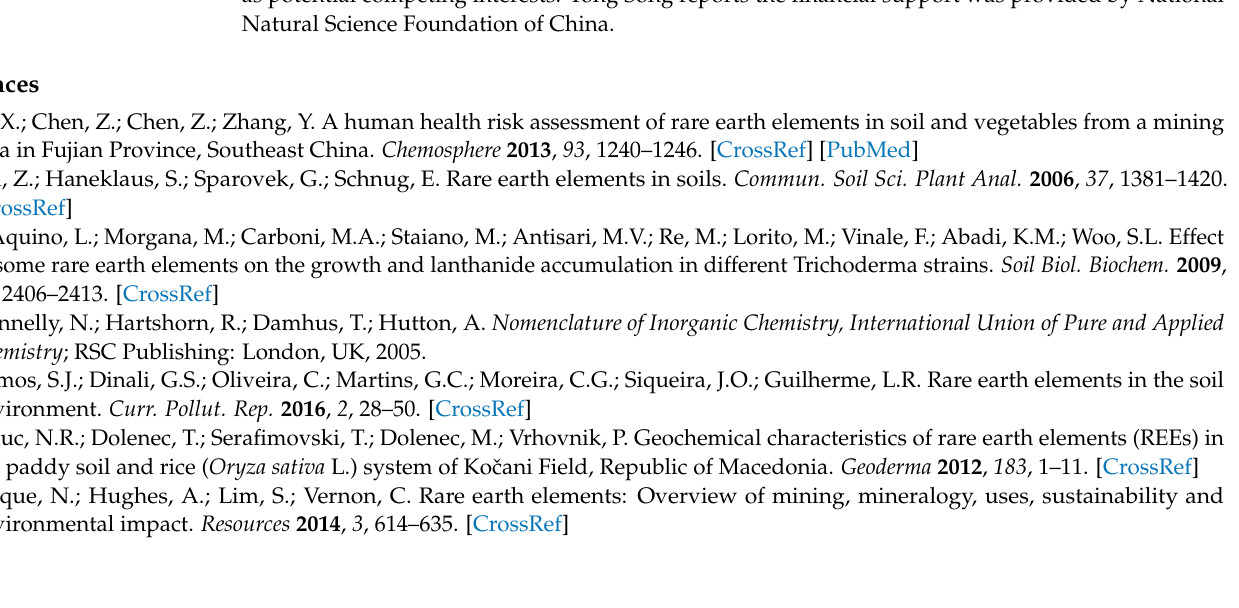
different food categories. Table S2. Concentrations of Ce in different food categories. Table S3. Concentrations of La in different food categories. Table S4. Concentrations of Y in different food categories. Table S5. The mean concentrations of 6 LREEs (La, Ce, Pr, Nd, Sm, Sc) in different food categories. Table S6. The mean concentrations of 10 HREEs (Eu, Gd, Tb, Dy, Ho, Er, Tm, Yb, Lu, Y) in different food categories. Table S7. The mean and P95 exposure of the 13 REEs (except Ce, La, and Y) in the general population and different sex-age groups of the Chinese population ( µ g/kg